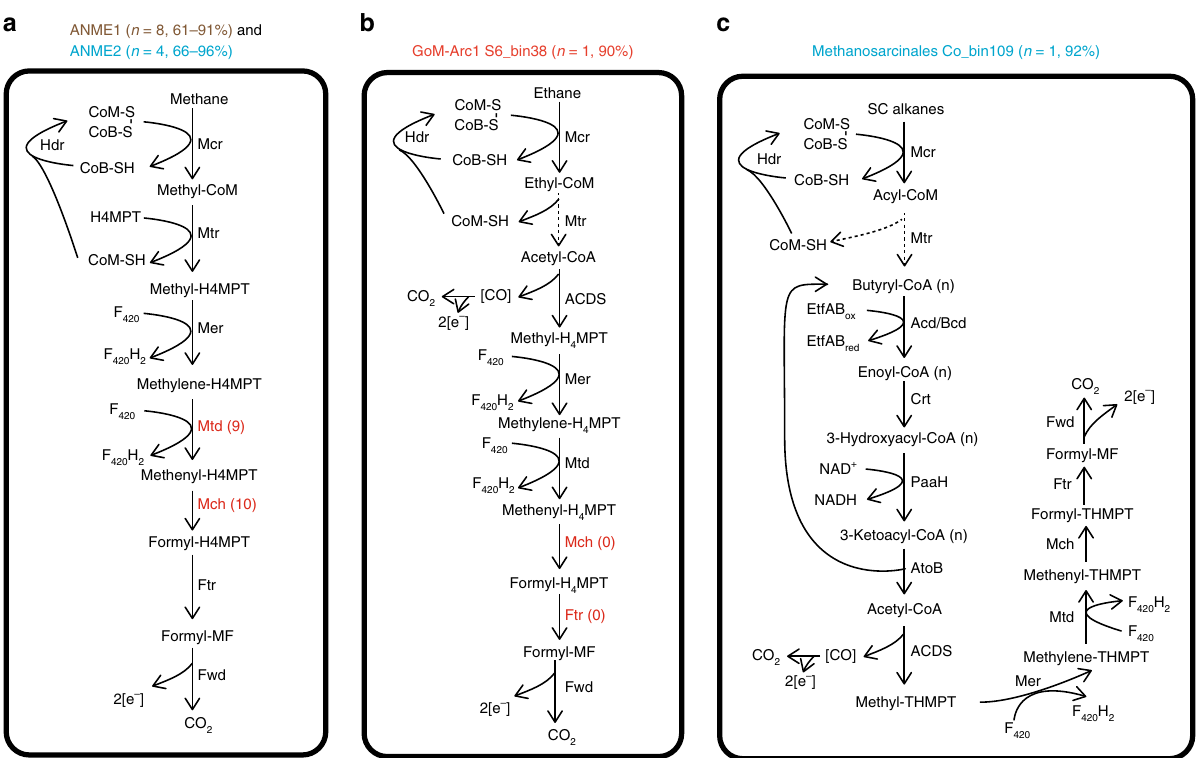
Fig. 5 Predicted metabolic models for anaerobic oxidation of gaseous alkanes based on archaeal MAGs harboring mcrA genes. a Archaeal oxidation of methane; b archaeal oxidation of ethane; and c archaeal oxidation of butane. Red font indicates that not all MAGs retrieved encode the enzyme (numbers of MAGs encoding the enzyme are indicated in parentheses). Dashed lines indicate steps catalyzed by uncon fi rmed enzymes. SC alkanes, short-chain alkanes. Percentages above each panel indicate the completeness of the corresponding MAGs estimated by CheckM. Details on the annotation of the enzymes are presented in Supplementary Data Syntrophobacterales encode alkylsuccinate synthase known to